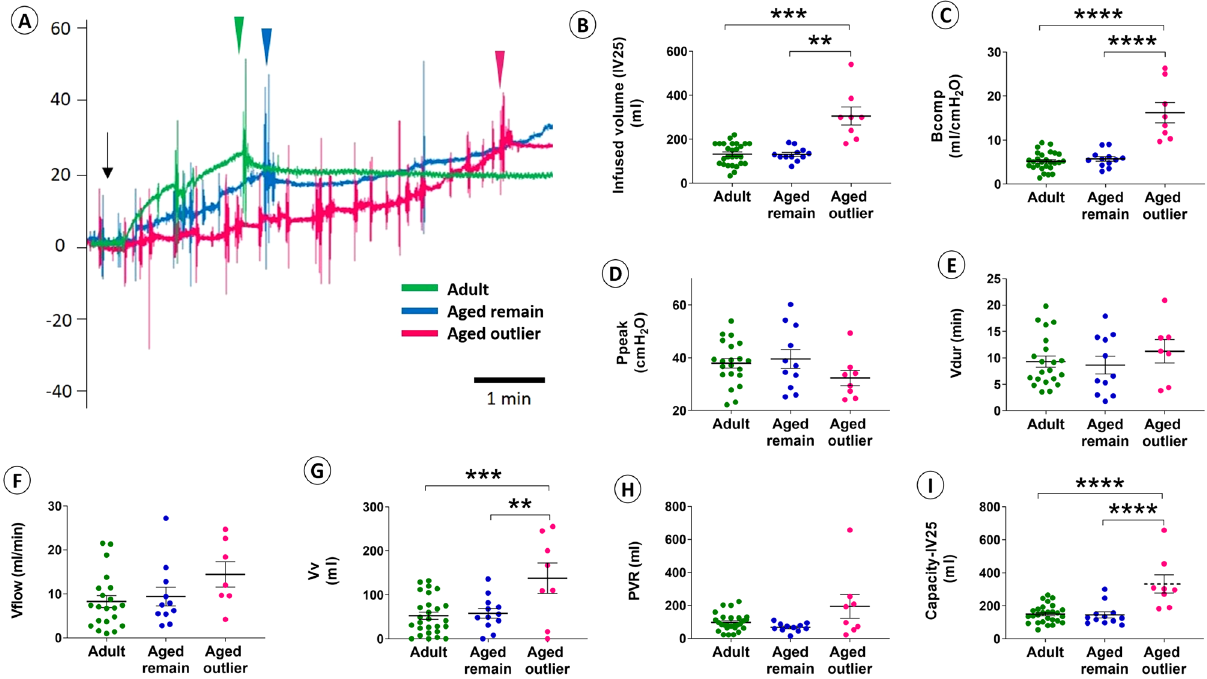
Figure 3. Urodynamic studies in adult, aged remain, and aged outlier rhesus macaques. Reflex micturition was evoked and shown by filling cystometry and pressure flow studies ( A ). The black arrow indicates start of bladder infusion, and the green, blue, and red arrow heads indicate end of infusion to reach target P∆ fill of 25 cm H 2 O in representative adult, aged remain, and aged outlier animals. Infused volumes were 120 ml in the adult, 120 ml in the aged remain, and 300 ml in the aged outlier subjects. Transient pressure spikes reflect movement artifacts during bladder infusion. There was a significant increase of IV25 for aged outliers compared to the aged remain group ( p < 0.01) and adults ( p < 0.001) but no difference between the adult and aged remain groups ( B ). There was a significant increase of Bcomp for aged outliers compared to the aged remain group ( p < 0.0001) and adults ( p < 0.0001) but no difference between the adult and aged remain groups ( C ). There was no detectable difference for Ppeak, Vdur, or Vflow between any of the cohorts ( D , E , F ). There was a significant increase in Vv for aged outliers compared to aged remain ( p < 0.01) and adults ( p < 0.001) but no difference between the adult and aged remain groups ( G ). There was no detectable difference for PVR between any of the cohorts ( H ). There was significant elevation of Capacity-IV25 for aged outliers compared to the aged remain ( p < 0.0001) and adult ( p < 0.0001) groups but no difference between the adult and aged remain groups ( I ). Data plots are presented as mean ± SE, and statistics are shown as * indicating p < 0.05, ** indicating p < 0.01, *** indicating p < 0.001,